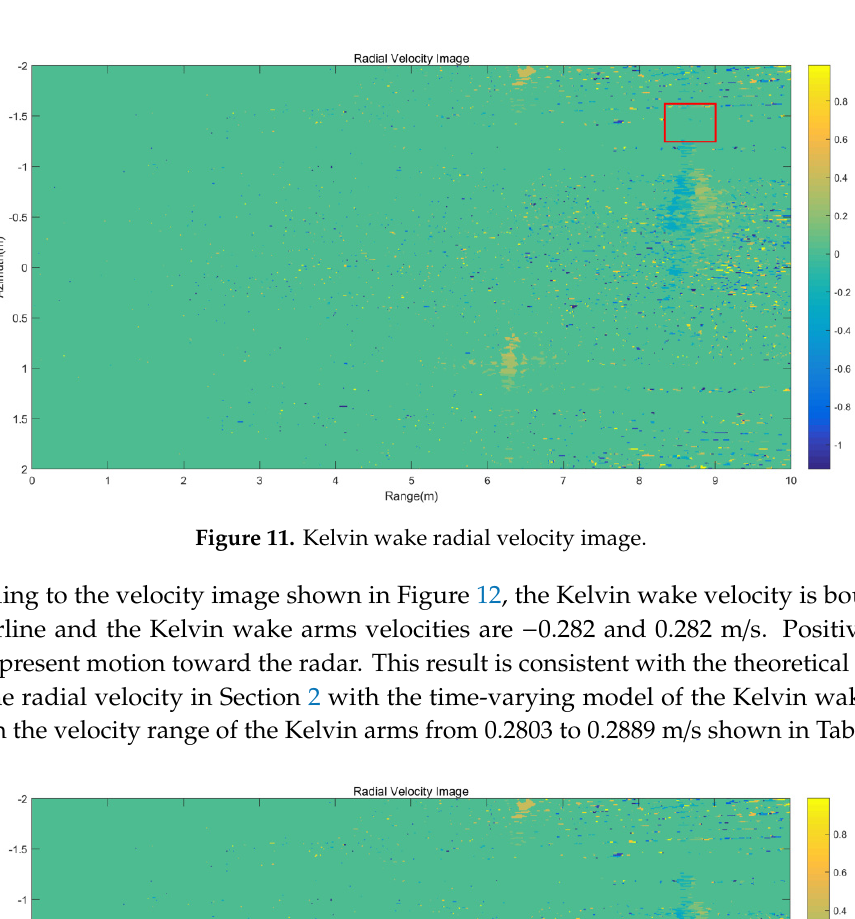
Figure 10. Two-dimensional wave spectrum with the measured wind speed.